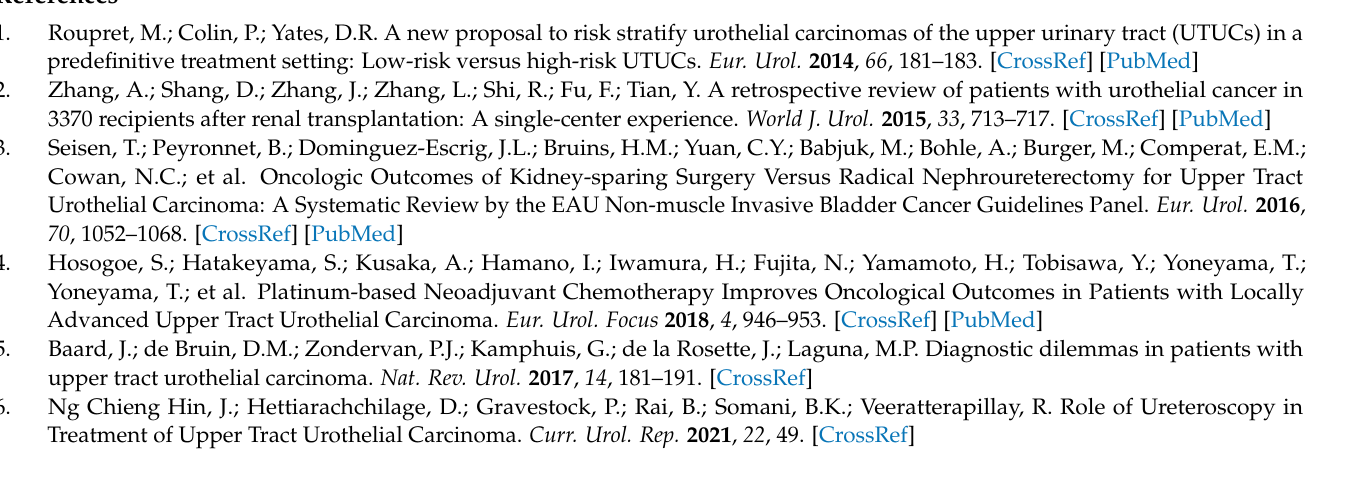
Table S2: Comparison of basic characteristics between training set and test